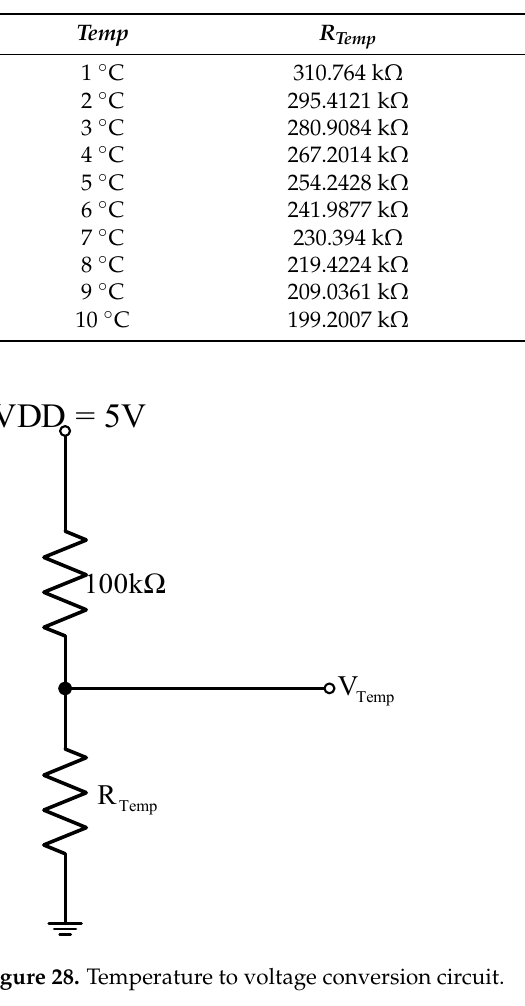
Table 9. The relationship between the temperature and the thermistor [24].